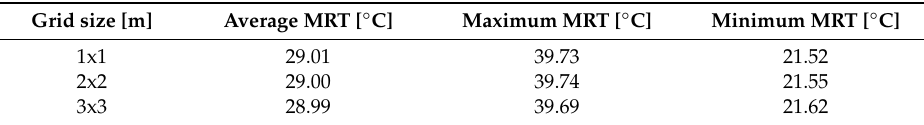
Table 3. Comparison of computed MRT values for three di ff erent grid